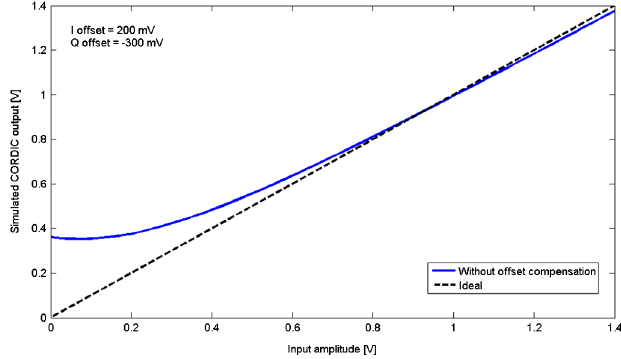
4. Top: Comparison between the measured and calculated results of the amplitude error caused by the I/Q gain and phase imbalances, Bottom: Calculated results of the phase error caused by the same gain and phase